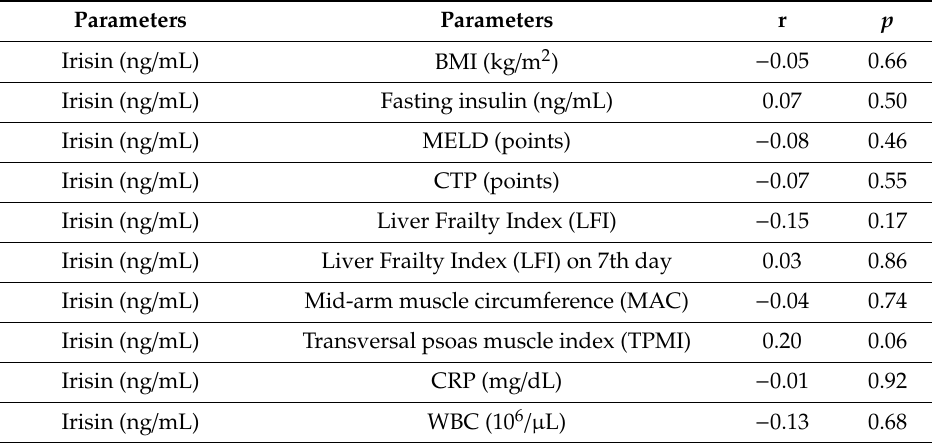
Table 9. Correlation between serum irisin with some analyzed parameters.